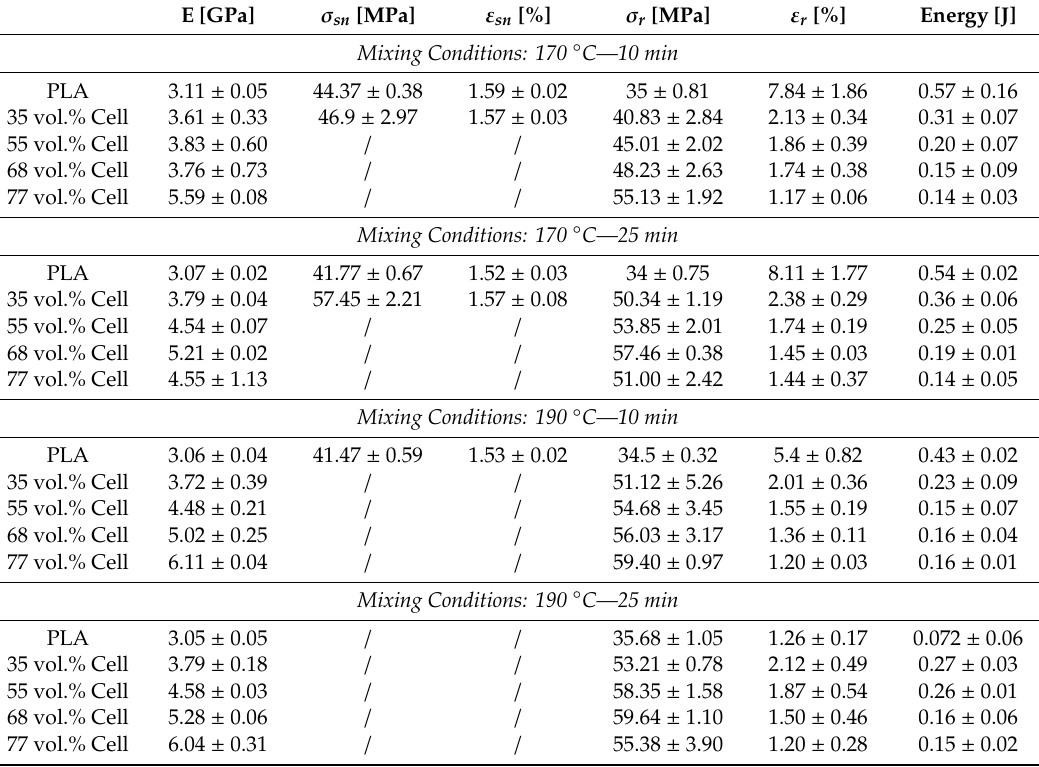
Figure 8. Representative stress–strain curves for the PLA matrix processed in different conditions of temperature and time. Table 4. Tensile mechanical features, young modulus (E), stress ( σ sn ) and strain ( ε sn ) at the yielding point and / or stress ( σ r ) and strain ( ε r ) at the breaking point, of the prepared compounds in the various adopted mixing